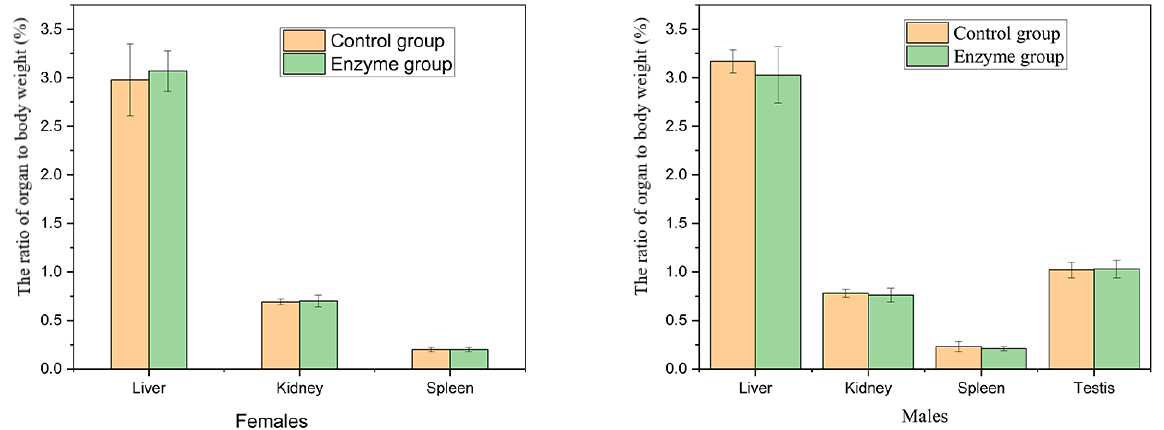
Figure 5. Effects of enzyme solution on organ to body weight ratio in rats ( n = 5).